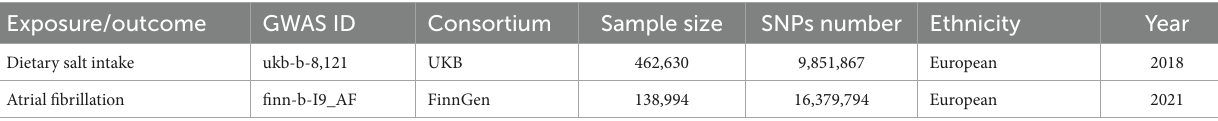
TABLE 1 Details of studies included in Mendelian randomization